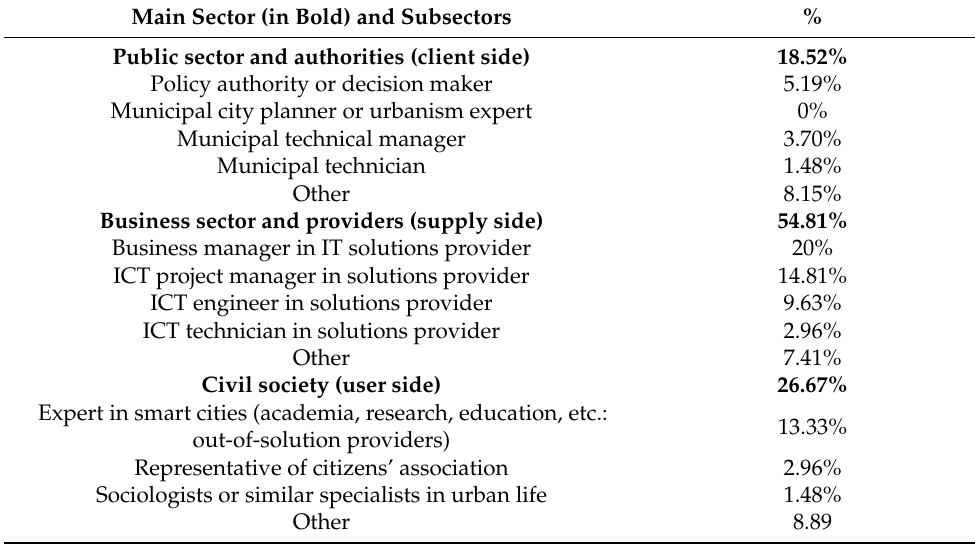
Table 1. Distribution among roles of different